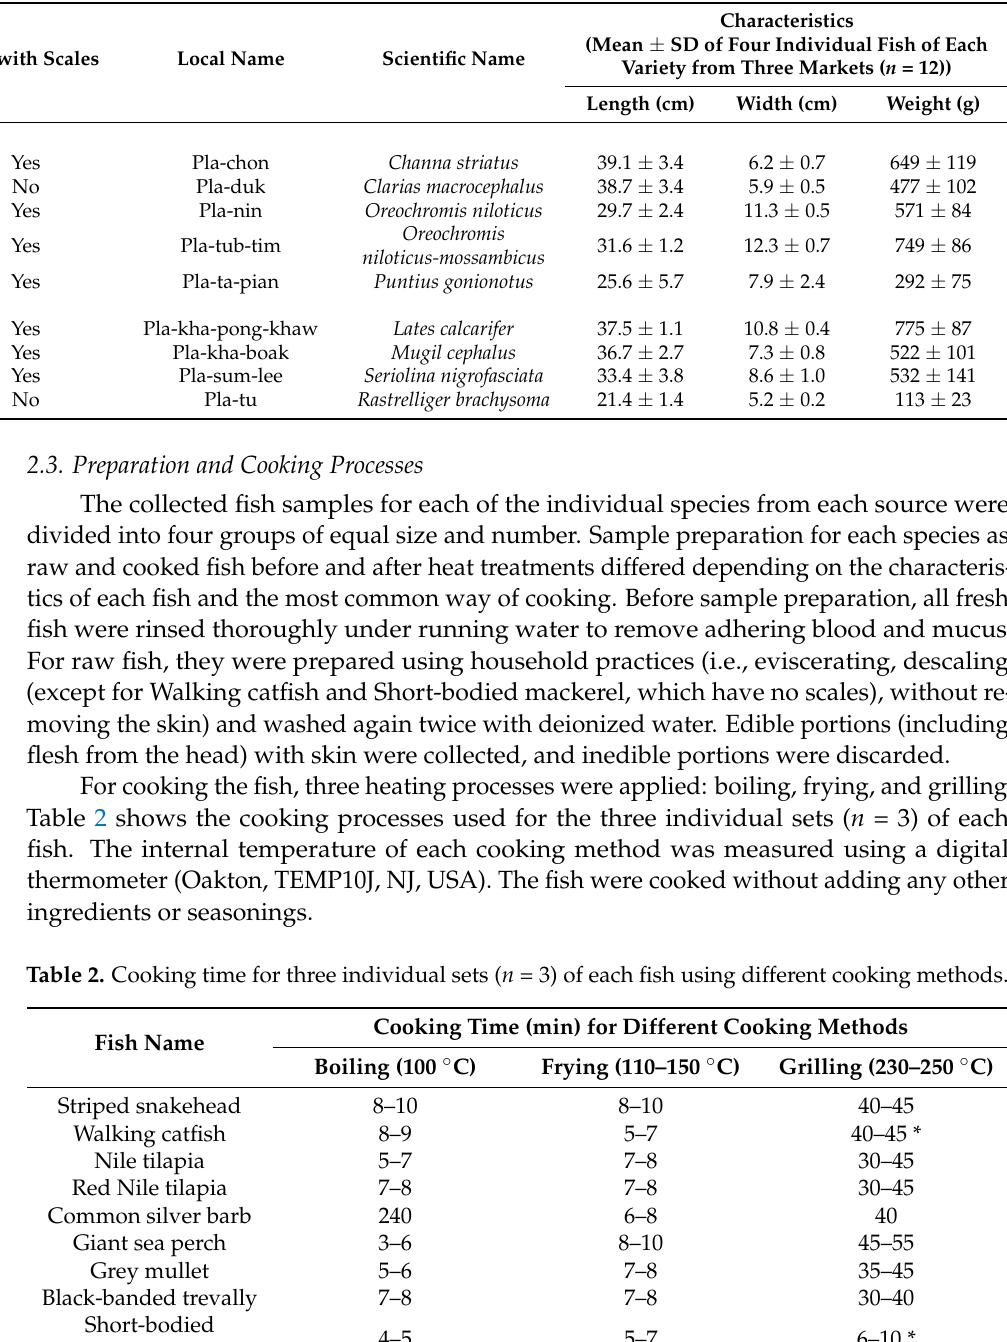
Table 1. Names and characteristics of selected commonly consumed freshwater and marine fish.